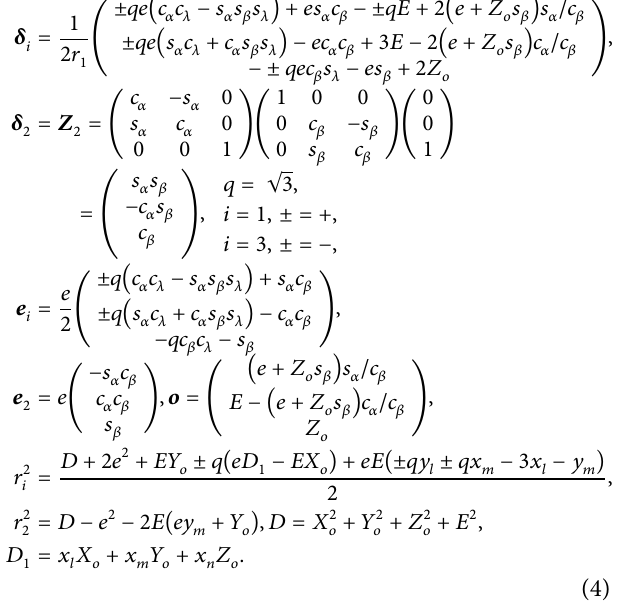
The force situation of the 2SPS + RRPR PM is shown in Figure 2. The whole workloads can be simplified as a wrench ( 𝐹 𝑇 ) applied onto m at o . Here, 𝐹 is a concentrated , force and 𝑇 is a concentrated torque. ( 𝐹 𝑇 ) includes the , inertia wrench and the gravity of m , and inertia wrench and the gravity of the active legs and the external working wrench.